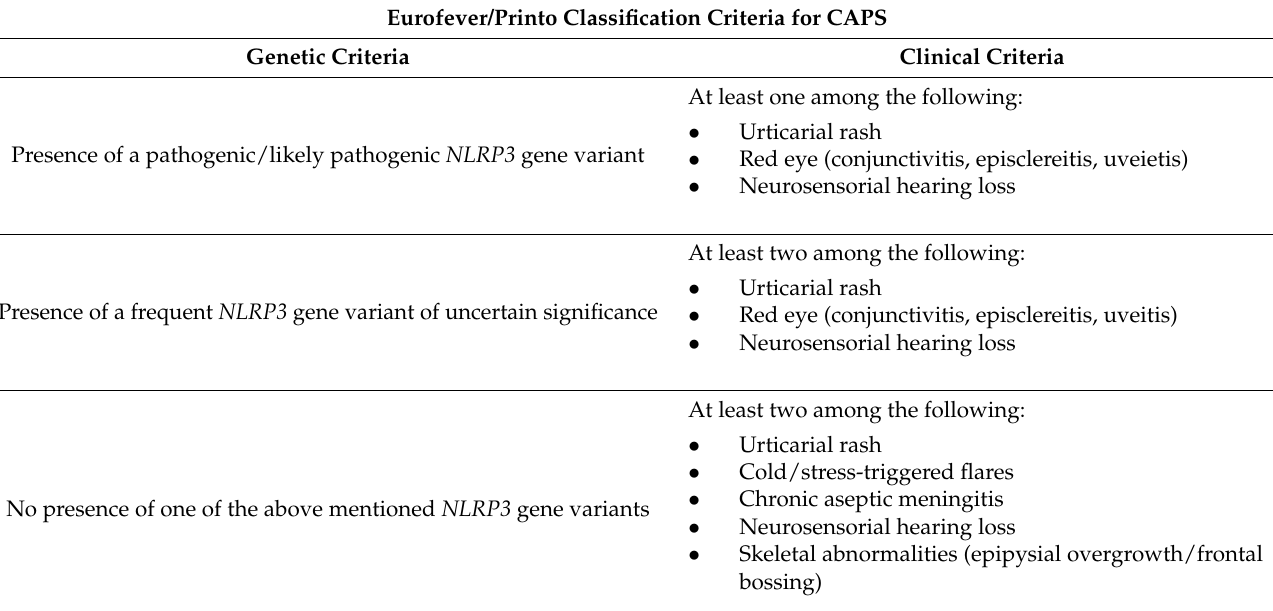
Table 3. Classification criteria for CAPS (data from